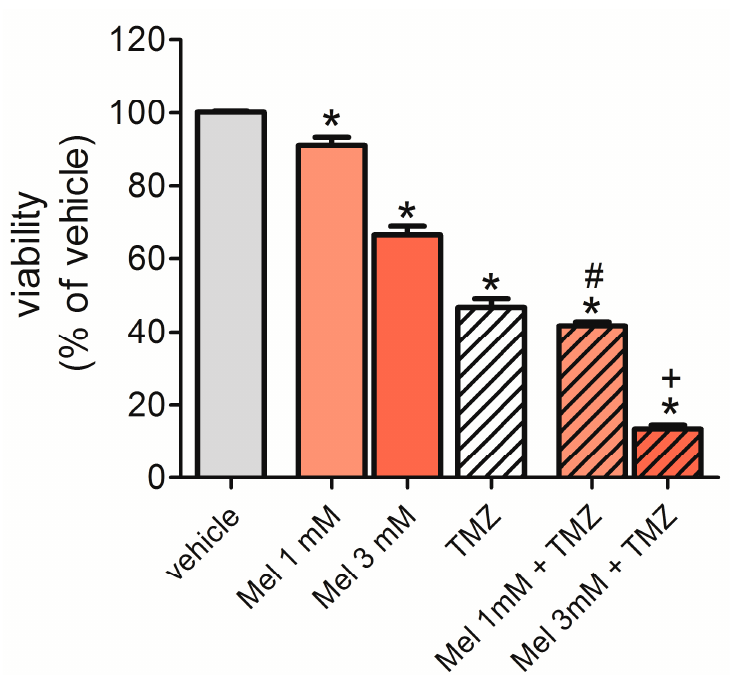
Figure 7. Melatonin potentiates the effect of temozolomide (TMZ) on cell proliferation/survival— U87MG cells were incubated with melatonin (1 mM or 3 mM) in combination or not with TMZ (0.8 mM) for 72 h, and the medium was exchanged every 24 h. Proliferation was assessed based on the reaction with PrestoBlue (Thermo Fisher Scientific), and the fluorescence was read on a GloMax ® 96 Microplate Luminometer (Promega Corporation). The results are presented as a percentage of the vehicle of each group. Proliferation did not differ between the vehicle-treated groups, and these groups were represented as a single bar. * p < 0.05 compared to vehicle, # p < 0.05 compared to the group treated with 1 mM melatonin, and + p < 0.05 compared to the group treated with 3 mM melatonin. The statistical analysis consisted of an ANOVA followed by Bonferroni’s post-hoc test.